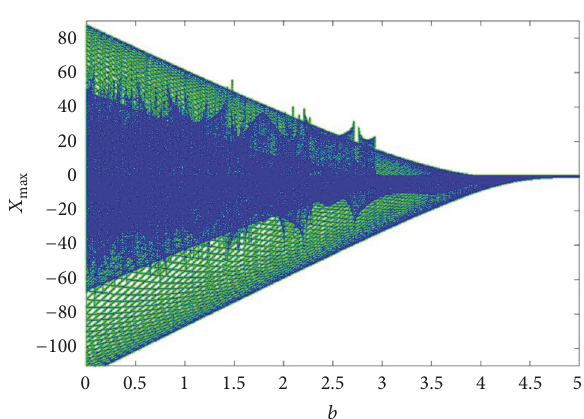
Figure 8: Bifurcation plots for parameter 𝑑